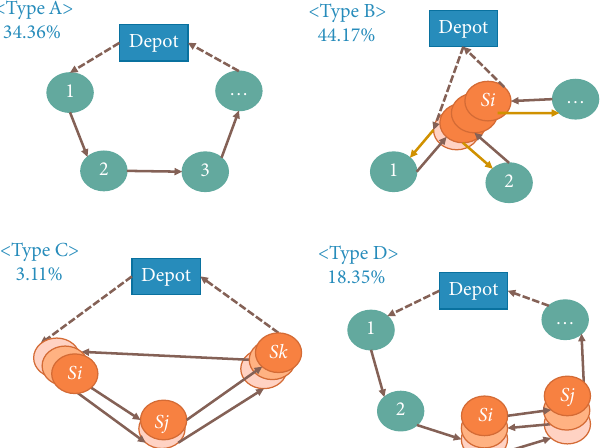
Figure 1: Drayage truck tour types, in which 𝑆𝑖 , 𝑆𝑗 , and 𝑆𝑘 are location indicators for the ports of Long Beach and Los Angeles, and near-dock and off-dock intermodal facilities ( 𝑖 ̸= 𝑗 ̸= 𝑘 ), Source: You and Ritchie (2018).